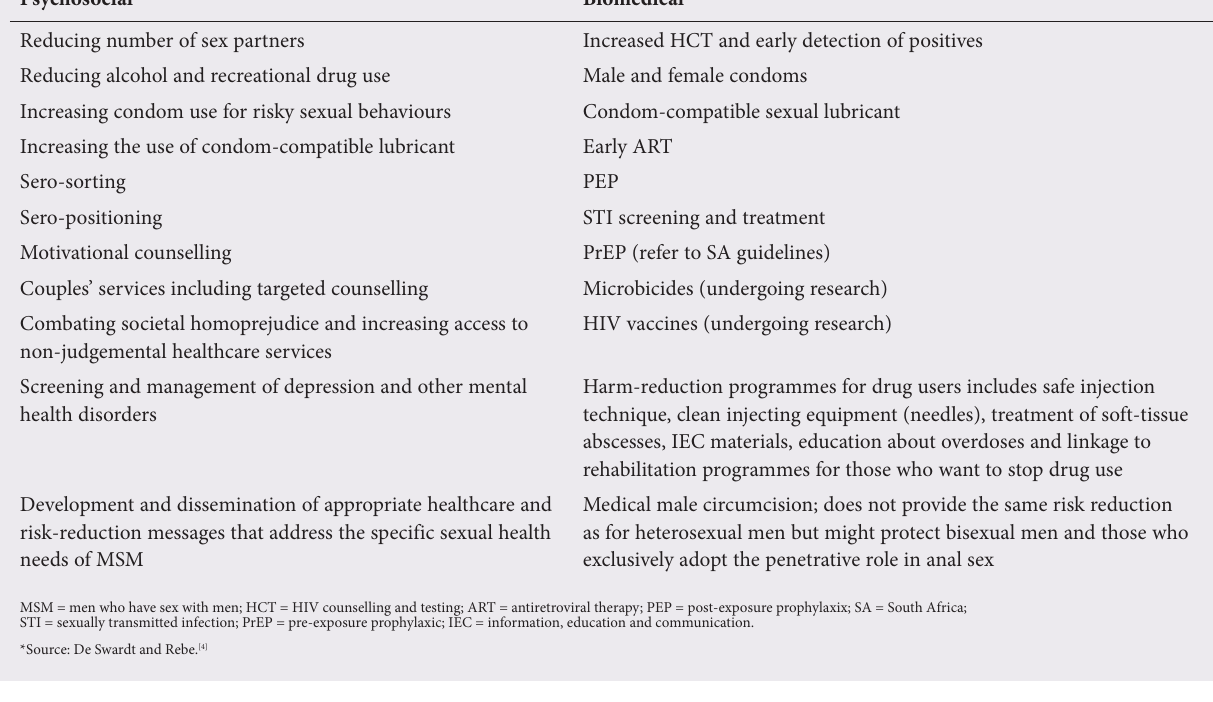
Table 3. Examples of interventions for preventing HIV among MSM* Psychosocial